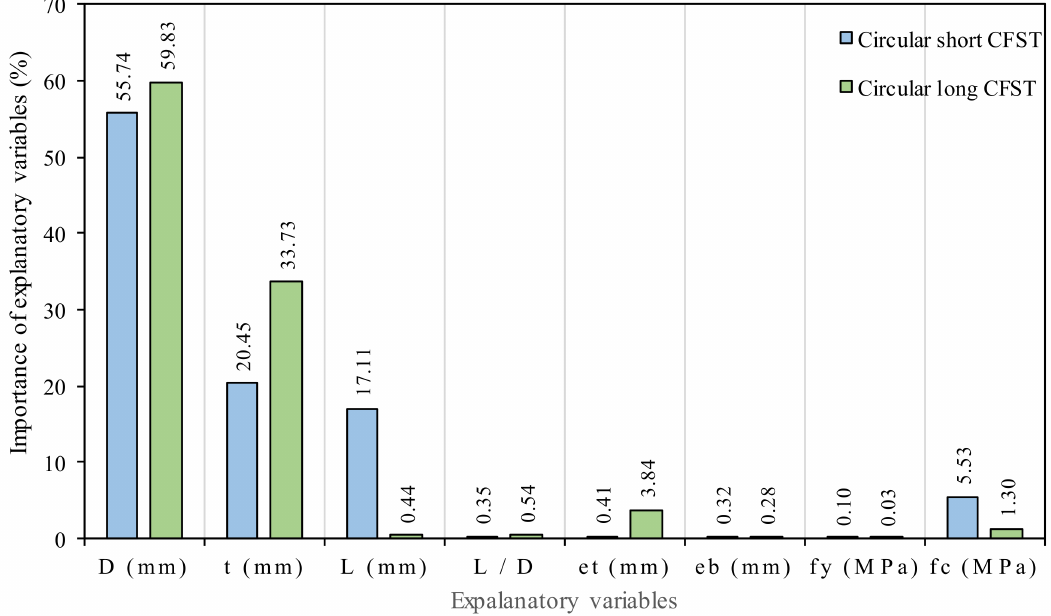
Figure 10. Relative importance of input variables on the bearing capacity of short and long circular CFST